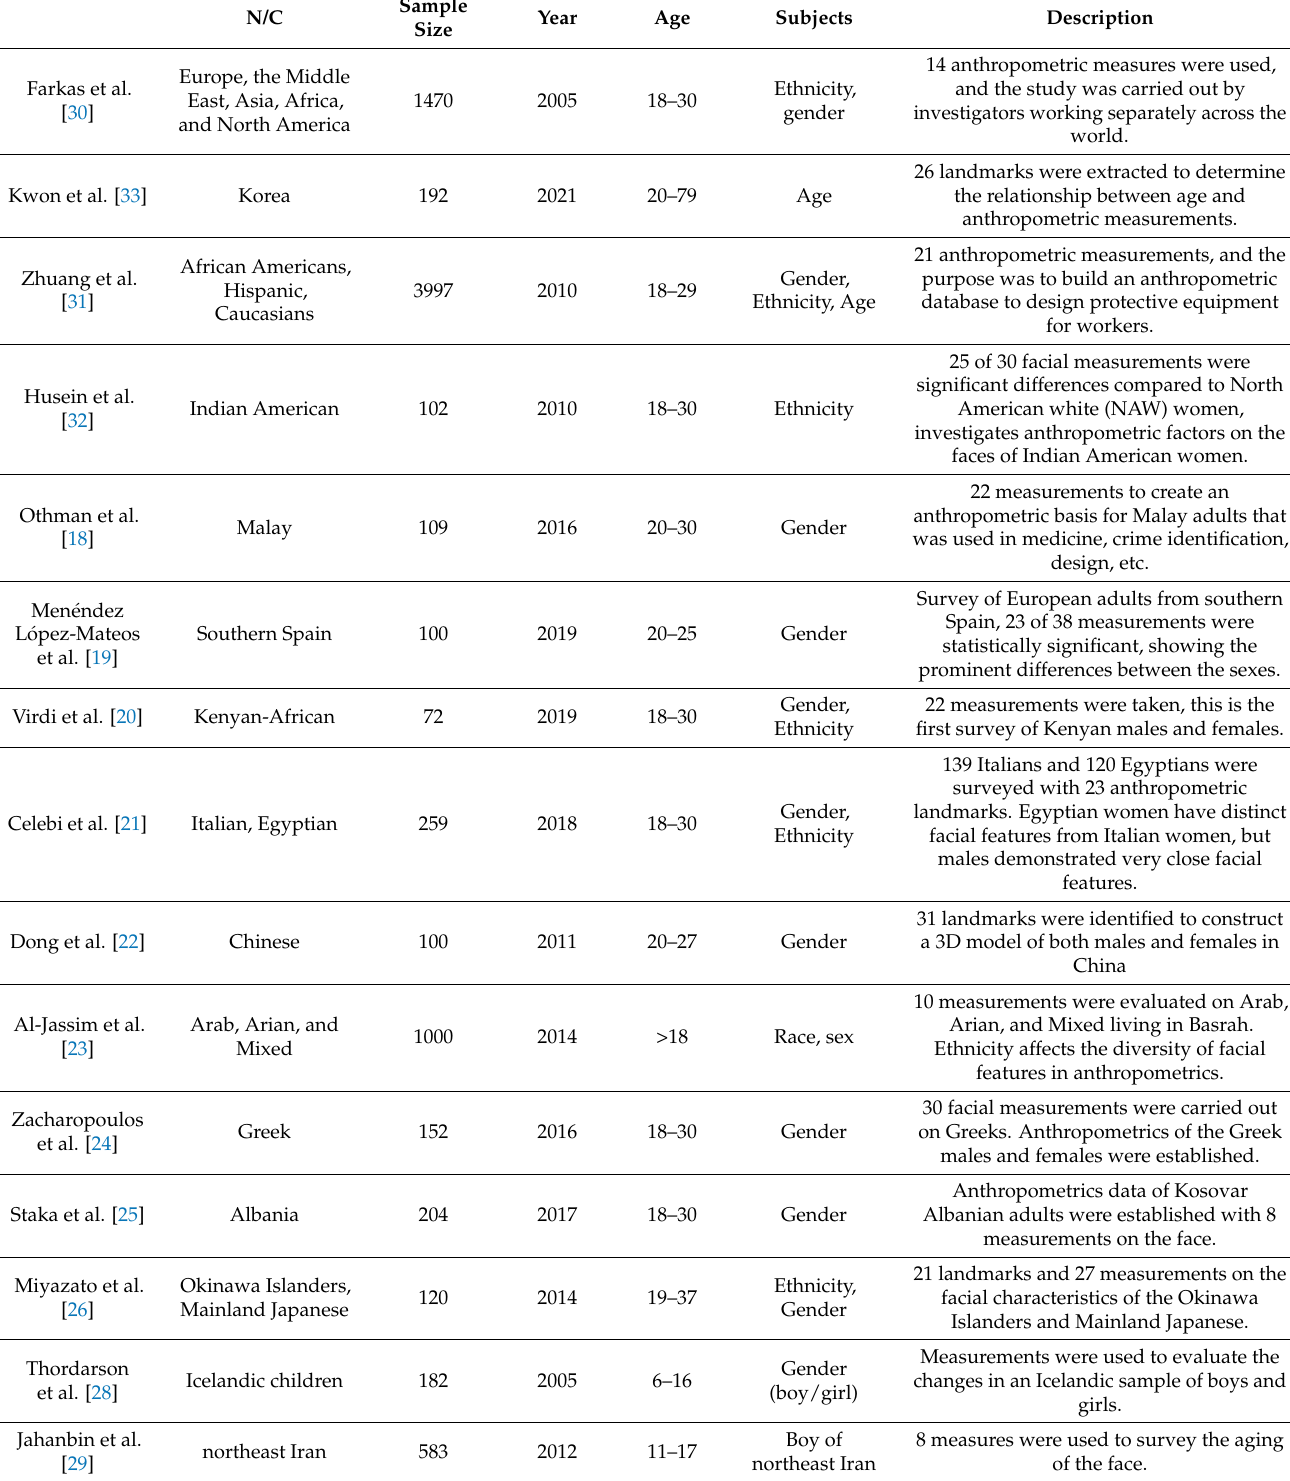
Table 1. Statistical tables of anthropometric data of the reviewed